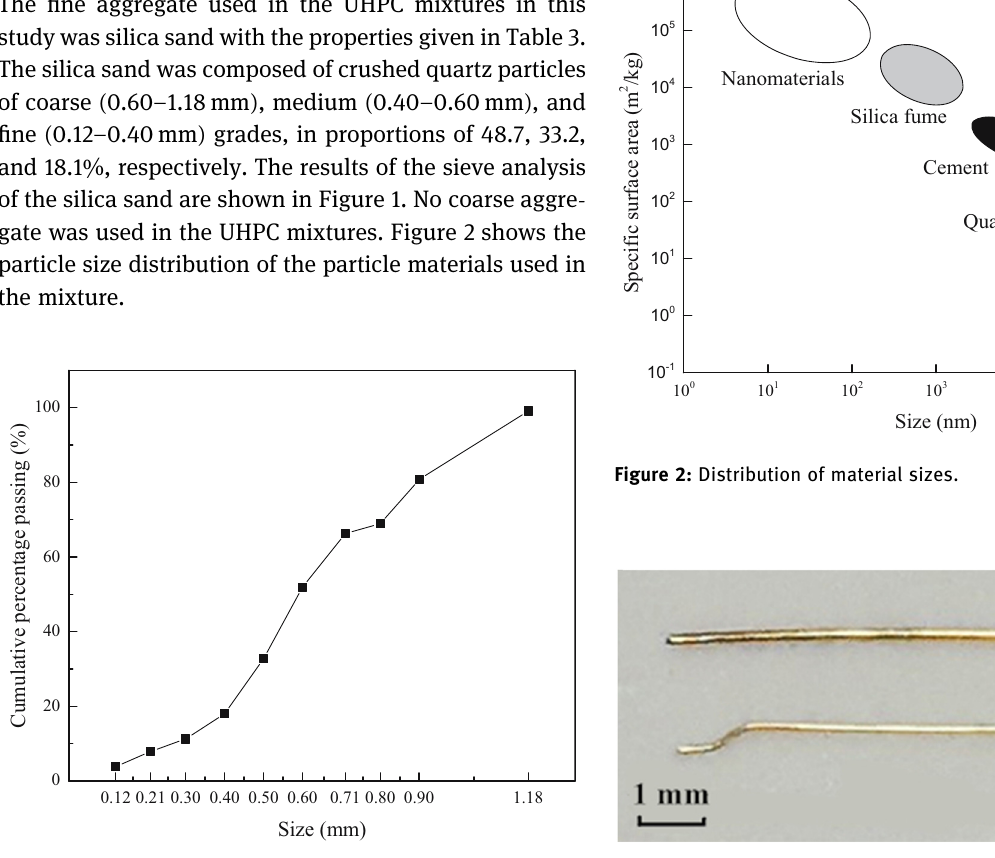
Figure 3: Steel fi